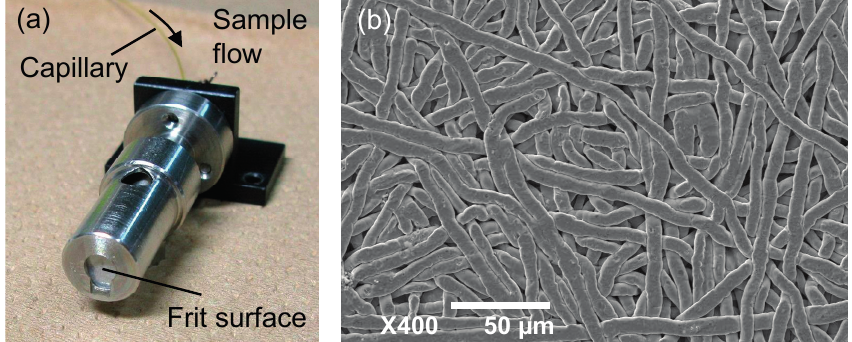
Figure 8. ( a ) Photograph of the frit probe and ( b ) scanning electron microscope image of the frit